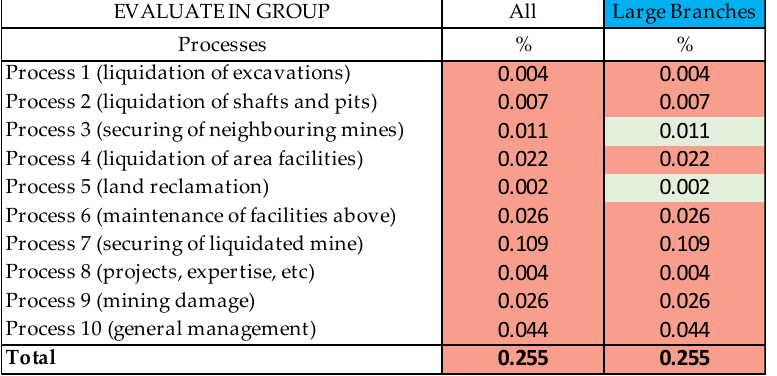
Figure 5. Assessment of the hypothetical branch B18 with twice value of the liquidation cost of branch B2.